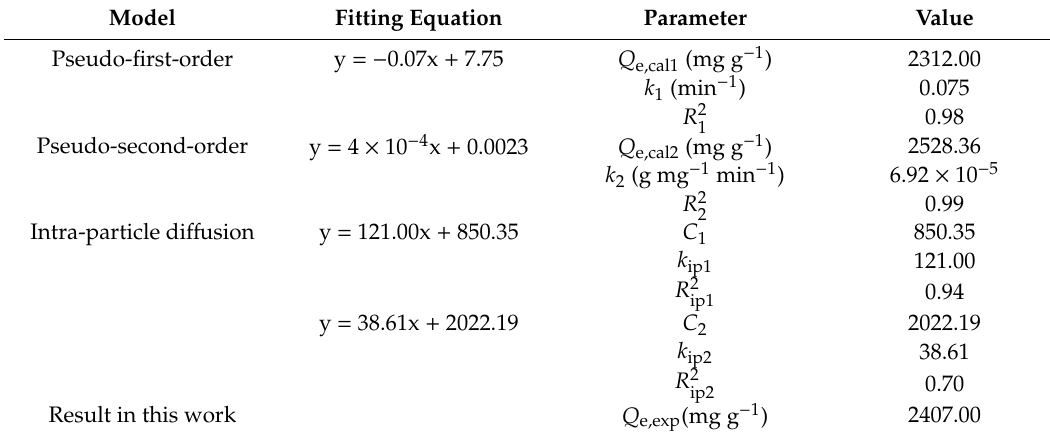
Comparison parameters of the pseudo-first-order, the pseudo-second-order and